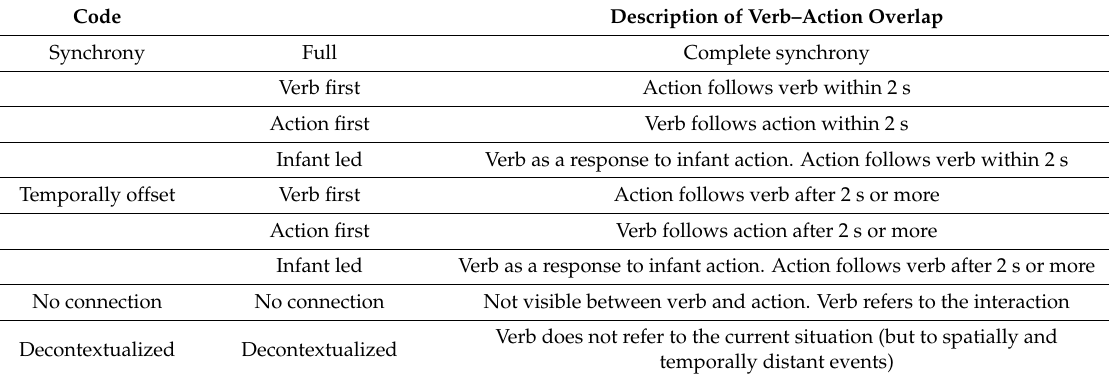
Table 1. The coding